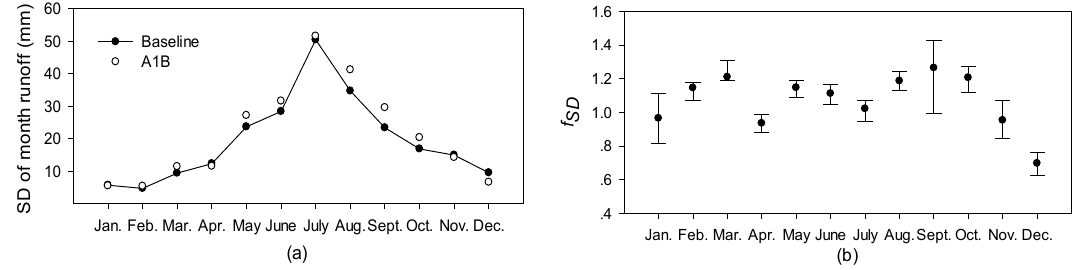
Jan. Feb. Mar. Apr. May June July Aug.Sept.Oct. Nov.Dec. (a) Fig. 4 Changes in mean monthly runoff in the Wuxuan watershed: (a) comparison between the baseline and A1B mean monthly runoffs; and (b) monthly runoff-change statistic f MEAN with its 95% CI.